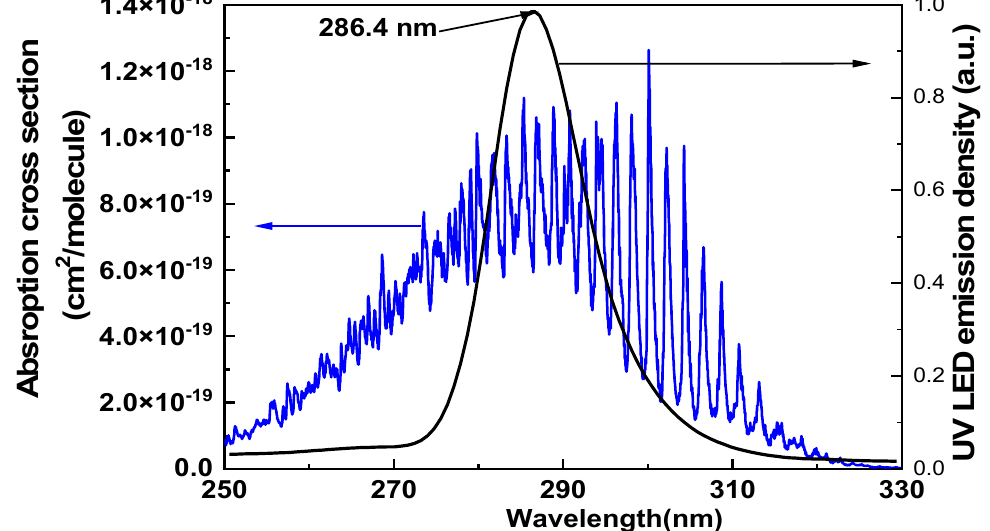
Figure 5. The emission spectrum of LED and absorption characteristics of SO 2 in the range from 250 nm to 330 nm.